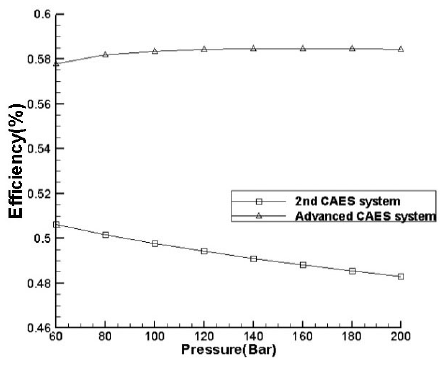
Figure 14. Effect of changes inair storage chamber pressure on efficiency.